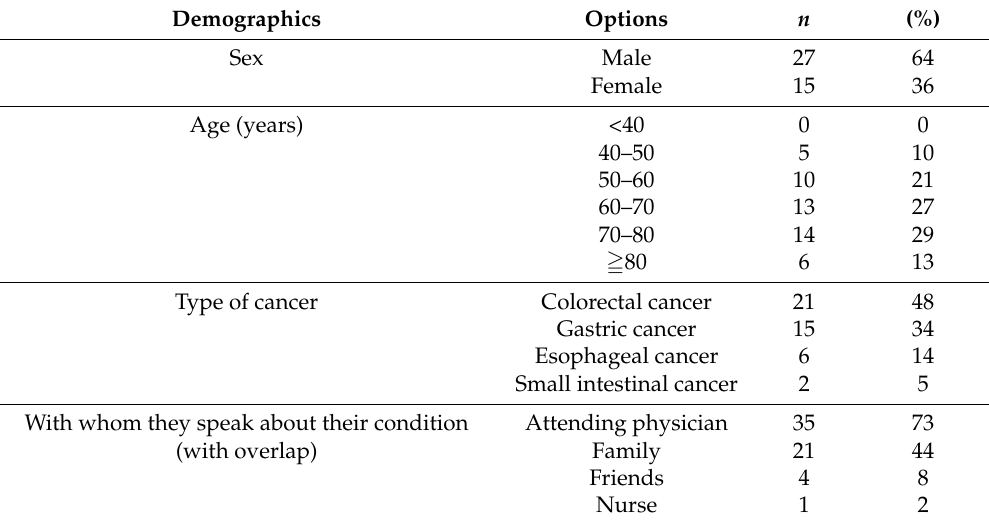
Table 1. Demographic